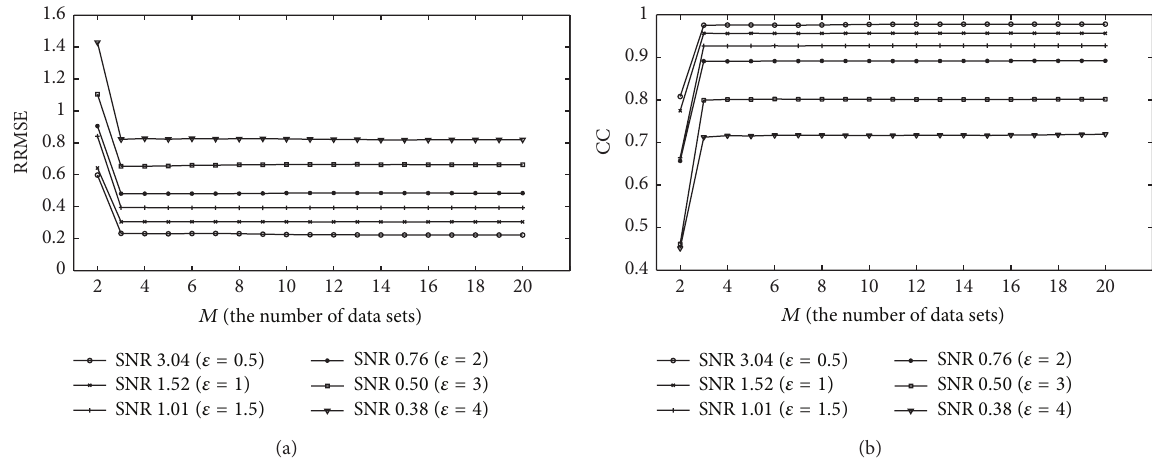
Figure 4: The performance measure in different 𝑀 and SNR values: (a) RRMSE and (b) CC.